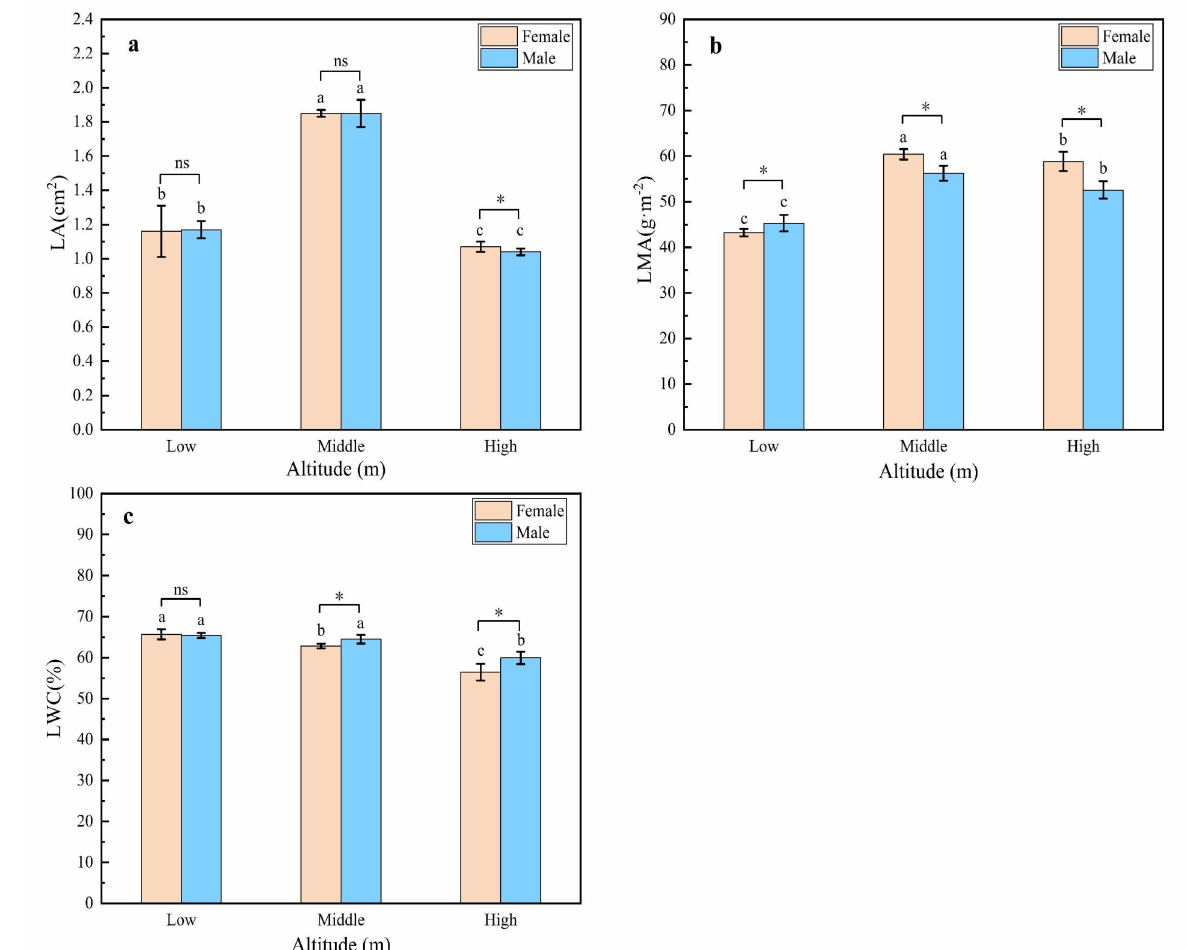
Figure 3. LA (leaf area), LMA (specific leaf weight) and LWC (leaf water content) of male and female leaves of H. tibetana measured at different altitudes. ( a ) LA of male and female H. tibetana at different altitudes. ( b ) LMA of male and female H. tibetana at different altitudes. ( c ) LWC of male and female H. tibetana at different altitudes. Different lowercase letters indicate significant differences ( p < 0.05) between male and female H. tibetana at different elevation gradients, while “*” and “ns” indicate significant differences and no significant differences between male and female plants at the same elevation gradient,